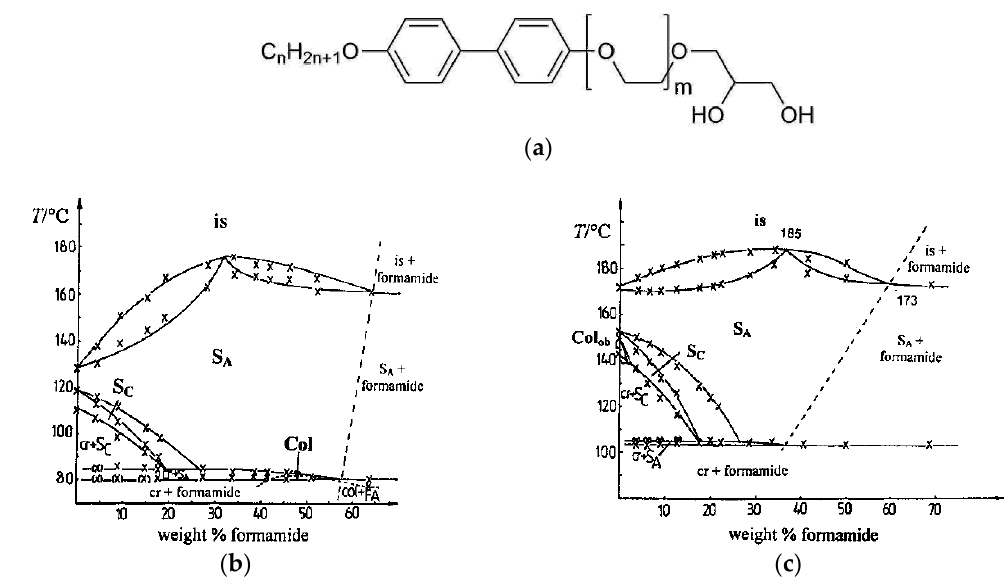
Figure 7. ( a ) Molecular constitution of a calamitic mesogen which incorporates a rigid biphenyl core and a diol moiety, the latter providing solubility in protic solvents. For ( b ) n = 12 and m = 3 and for ( c ) n = 10 and m = 1, the amphiphiles show a swollen SmC phase, denoted with S C in the phase diagram. In neither case, is the phase stable with mass fractions of formamide larger than approximately 15 wt%. (Phase diagrams reprinted with permission from Spie [19], and [20]. Copyright 1998 American Chemical Society.)